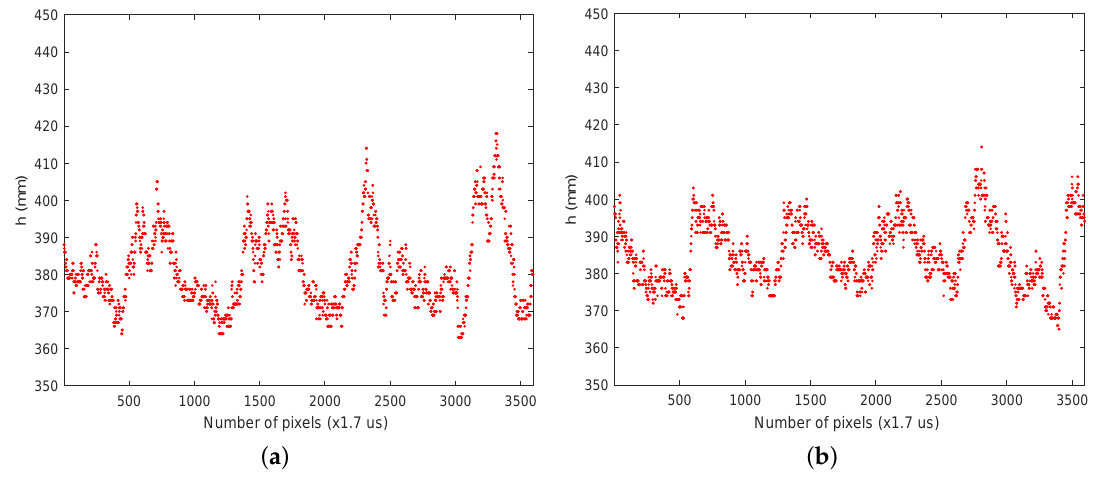
Figure 15. ( a ) Rotating stick at 21,000 rpm; ( b ) rotating stick at 26,000